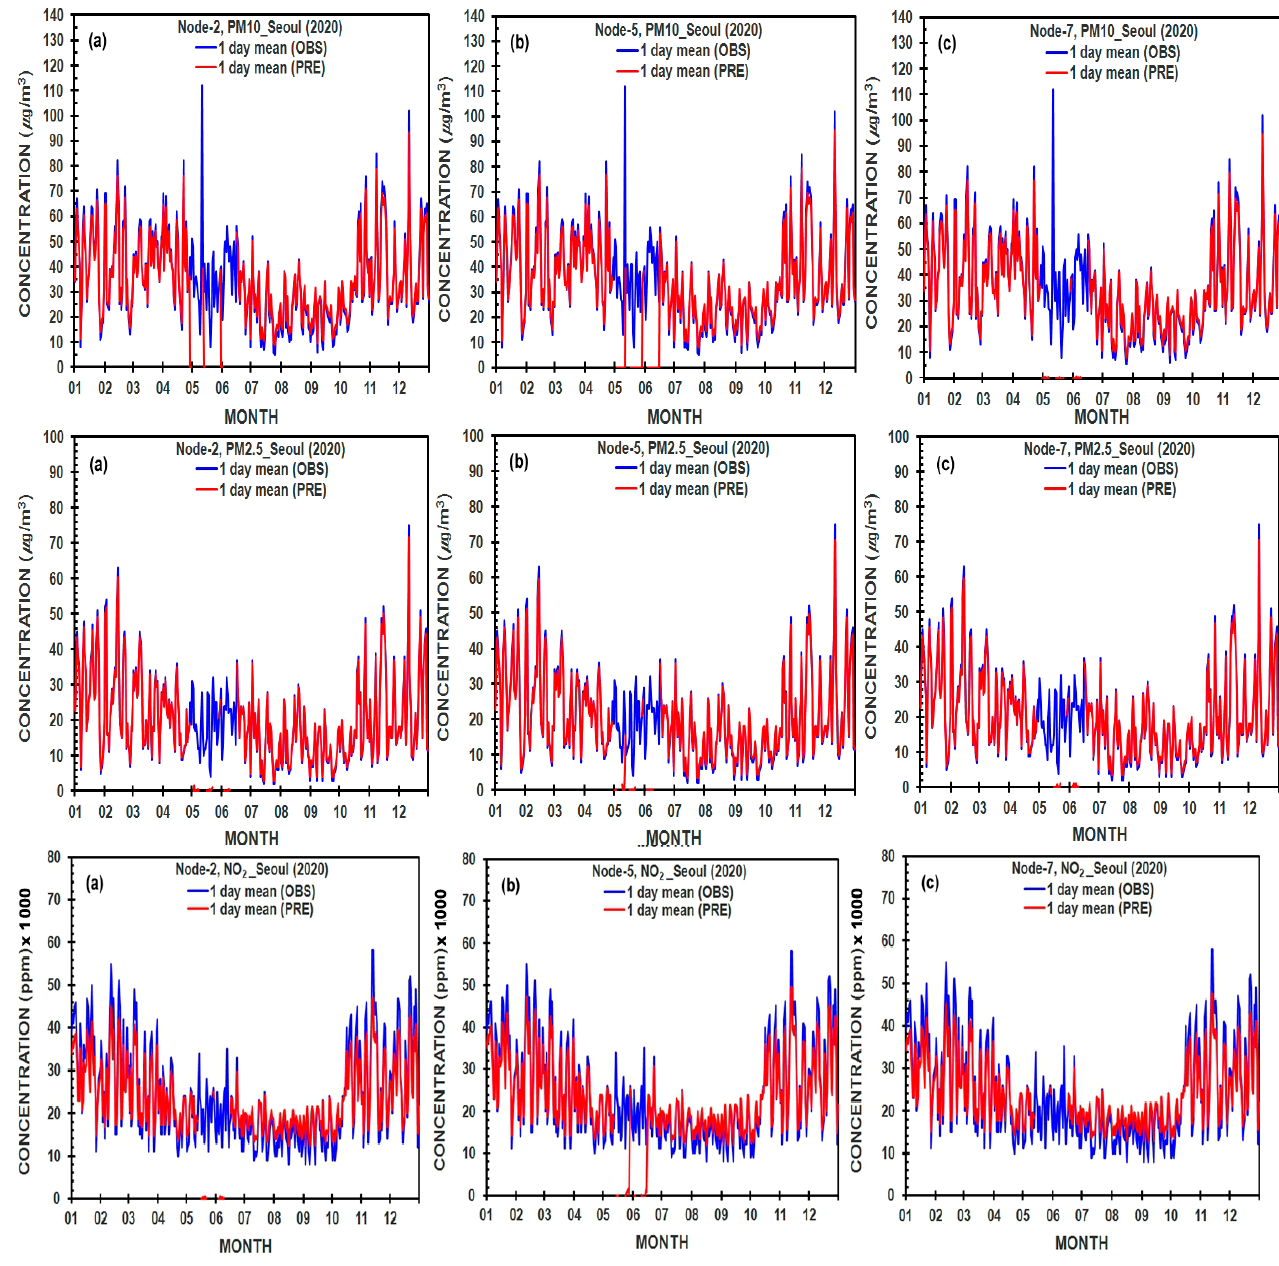
Figure 6. Comparison between predicted and measured daily averaged PM 10 ( μ g/m 3 ), PM 2.5 ( μ g/m 3 ), and NO 2 (ppm × 1000), concentrations, using different numbers of hidden neurons-2, 5, and 7 in an Artificial Neural Network Model-based a sigmoid activation function at Seoul city, Korea, during the COVID-19 epidemic year (2020).